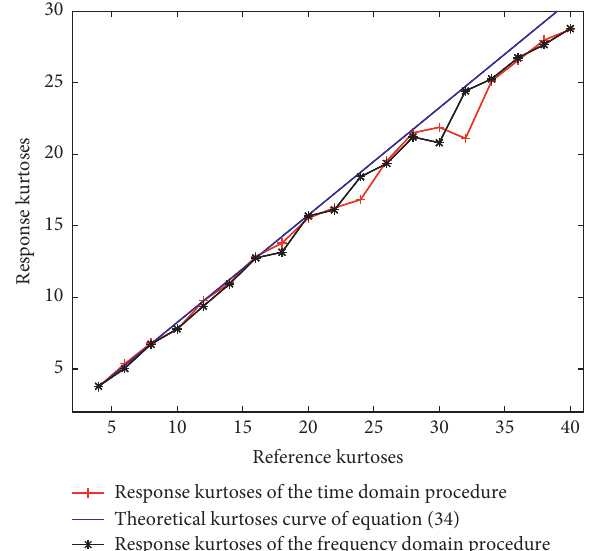
Figure 10: Numerical relation between the reference kurtoses and the response kurtoses: theoretical curve based on equation (34) (solid line); averaged kurtoses of the response using the time- domain procedure (broken line with plus signs); averaged kurtoses of the response using frequency-domain procedure (broken line with